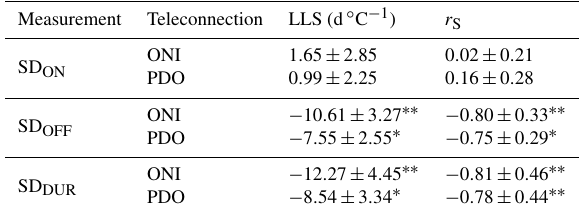
Table 1. Provincial summary of a linear least squares (LLS) regres- sion in days per teleconnection degree Celsius anomaly (d ◦ C − 1 ) and Spearman rank-order correlations ( r S ) for SD ON , SD OFF , and SD DUR with ONI and PDO. Coefficient significance is given by the number of stars next to a value. Teleconnection values are the annual mean of the four seasonal values (Fig. 2).